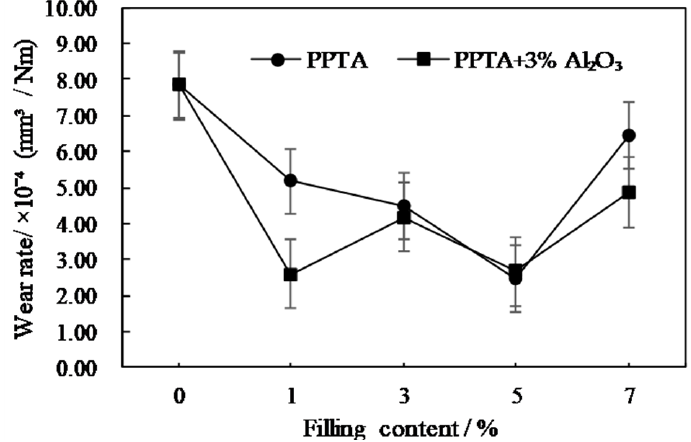
Figure 22. Wear rate of PPTA and nano Al 2 O 3 particles filled modified PTFE composite.